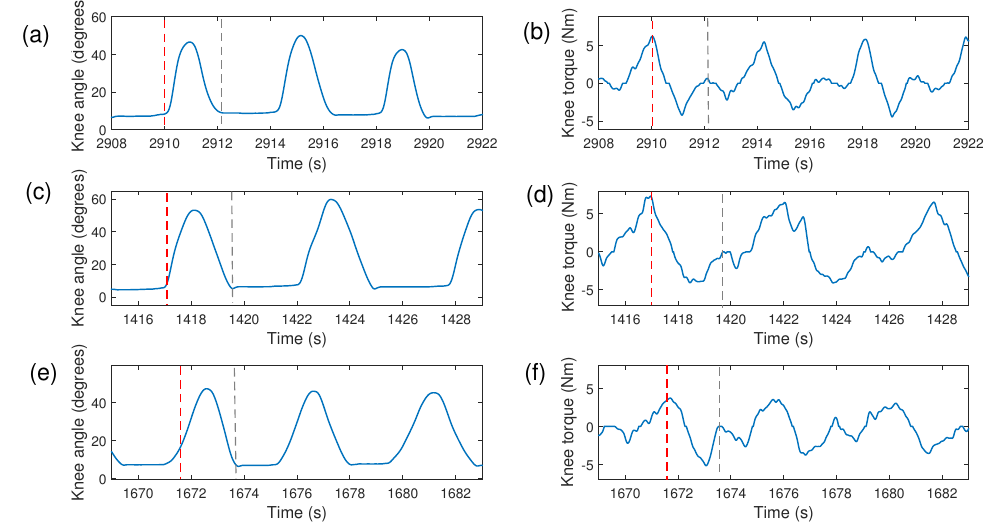
Figure 12. Knee angle and knee torque during knee impedance modulation with patterns G : P 1 ( a , b ); P 2 ( c , d ); P 3 ( e , f ).